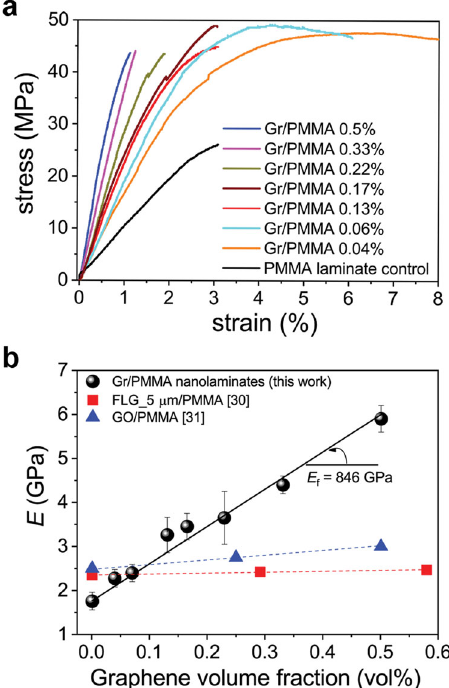
Fig. 3 Mechanical characterization of Gr/PMMA nanolaminates. a Representative stress-strain curves obtained by uniaxial tensile testing and b Young ’ s modulus (taken from the initial ~0.4% linear part of the curve) of the Gr/PMMA nanolaminates as a function of graphene volume fraction and respective comparison with typical discontinuous graphene composites (data taken from refs. 30,31 ). FLG: few-layer graphene. GO: graphene oxide. PMMA: poly(methyl methacrylate). Error bars represent standard